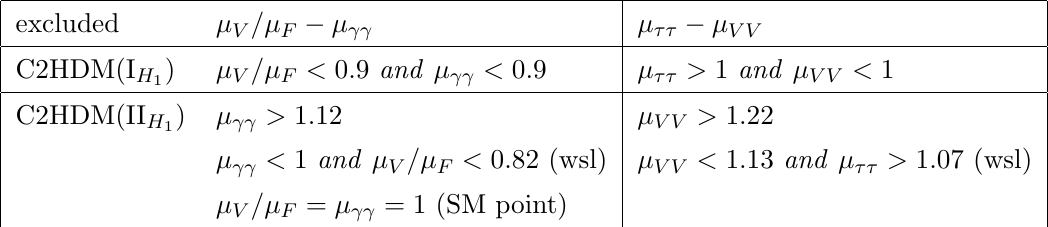
a strong PT. Their key features are summarised in table